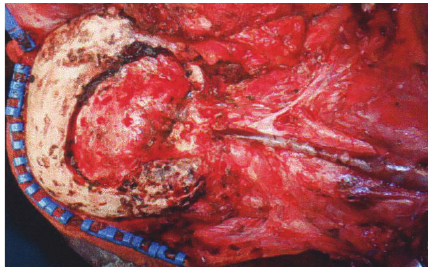
Figure 4: Postresection view. Temporal craniotomy and skull base surgery were performed and mandibular dissection was carried out. Facial nerves were resected at the same time.